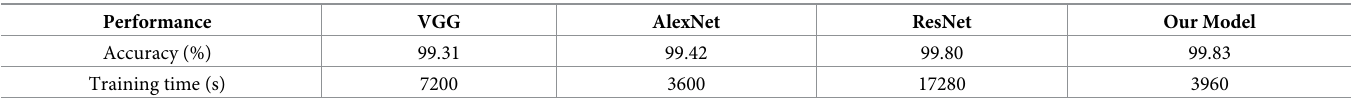
Table 1. Comparison of recognition performance of different